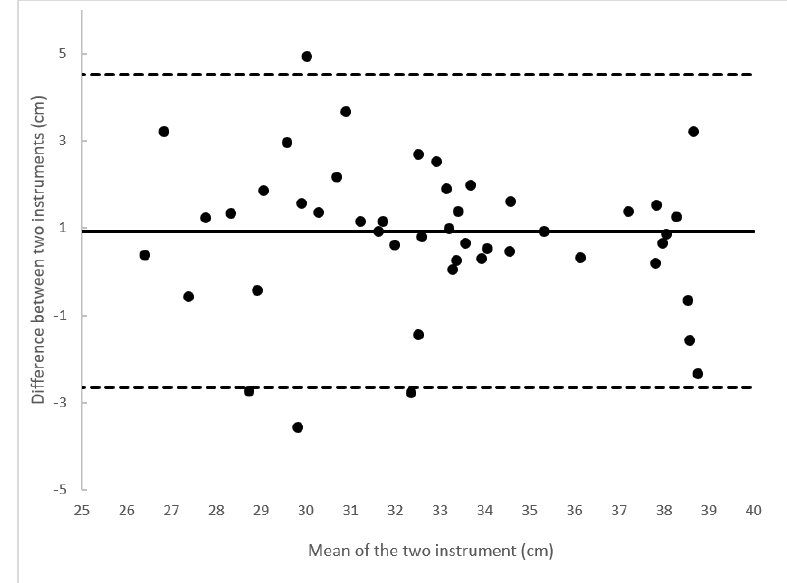
Figure 6. Bland–Altman plot between the FP using flight time and the APP using flight time to measure jump height. The central line represents the systematic bias between instruments, while the upper and the lower lines represent ± 1.96 SD; FP, force platform; APP, My Jump App; graph made by the authors. The one-way ANOVA shows a significant di ff erence between the JH measured with the FP through the TOV versus the APP ( p = 0.002), and a trend versus the FP through the FT ( p = 0.052). Finally, the JH analyzed with the FP through the FT and the APP did not di ff er ( p = 0.457) (Table 1). The eta squared of the one-way ANOVA was η 2 =